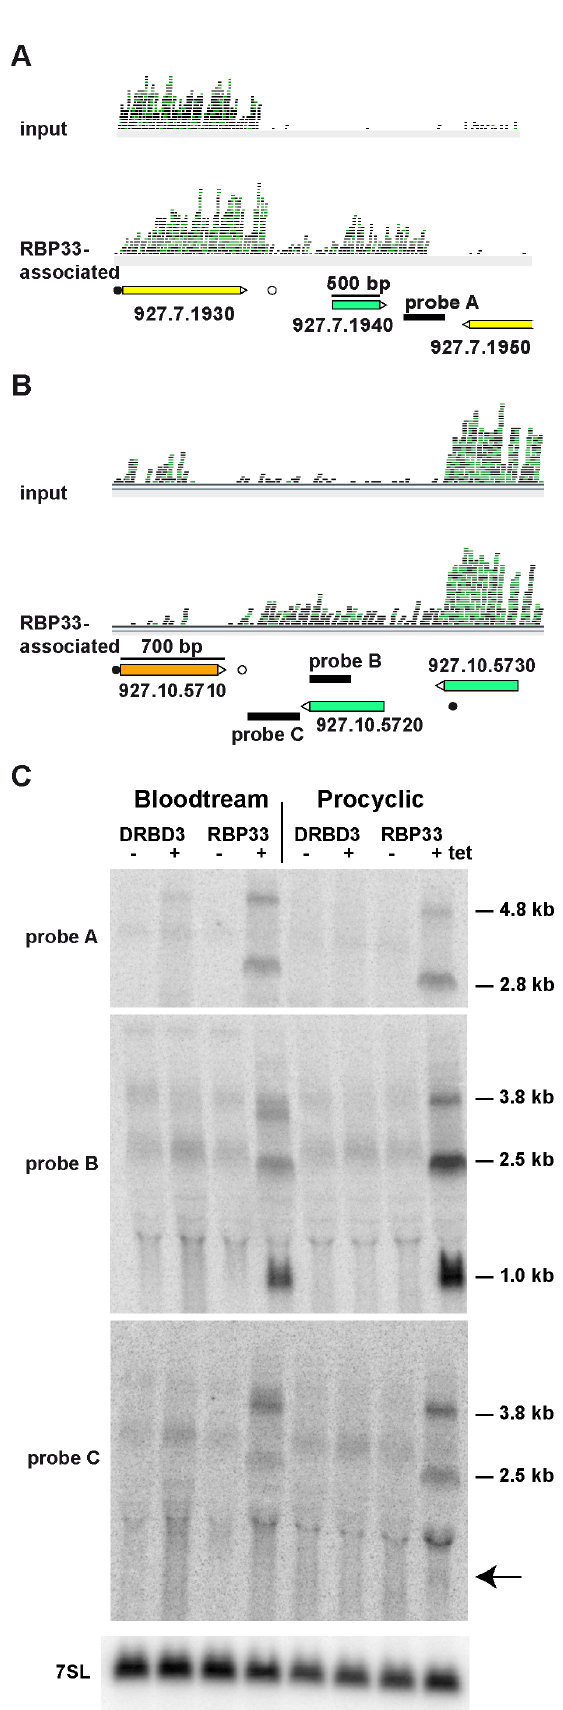
Figure 5. Effect of RBP33 depletion on the levels of SSR- derived transcripts. (A) Artmemis visualization of RNAseq data corresponding to the SSR downstream gene Tb927.7.1930 and to the SSR downstream gene Tb927.10.5710. Probes used for Northern blot analysis are indicated. ‘Input’ refers to the RNA-seq data obtained from total RNA before immunoprecipitation, whereas ‘RBP33-bound’ refers to the immunoprecipitated RNA using RBP33 specific antibodies. Anno- tated splice-acceptor and polyadenylation sites [13] are indicated as filled or empty circles, respectively. The splice-acceptor site for Tb927.10.5720 has been mapped in this study, and lies within the downstream open-reading frame. (B) Northern hybridizations using radiolabeled double-stranded DNA probes as indicated in panel A. An RNAi cell line expressing dsRNA against the essential RNA-binding protein DRBD3 [11] was used as a control. Total RNA was obtained from parasites grown in the absence ( 2 ) or the presence ( + ) of tetracycline for 48 h, transferred to nylon membranes and hybridized with specific probes. The 7SL RNA was used as a loading control. The arrow indicates the position of the 1.0 kb transcript detected with probe B.